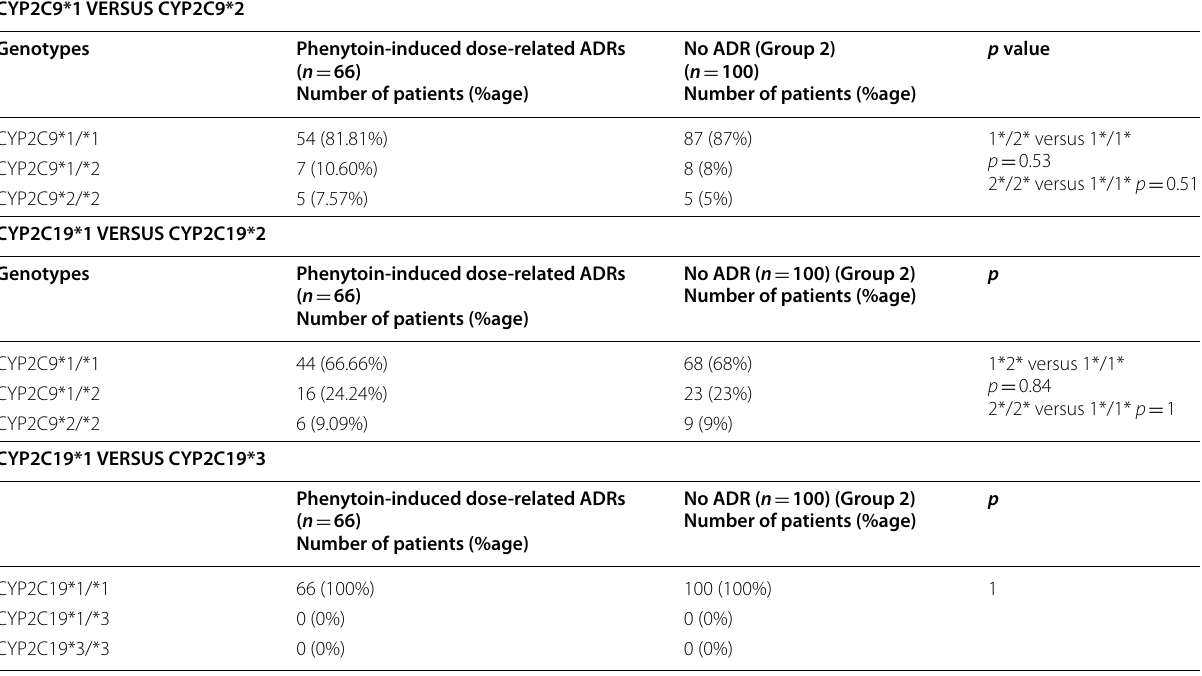
Bold values are significant when p -value is < 0.05